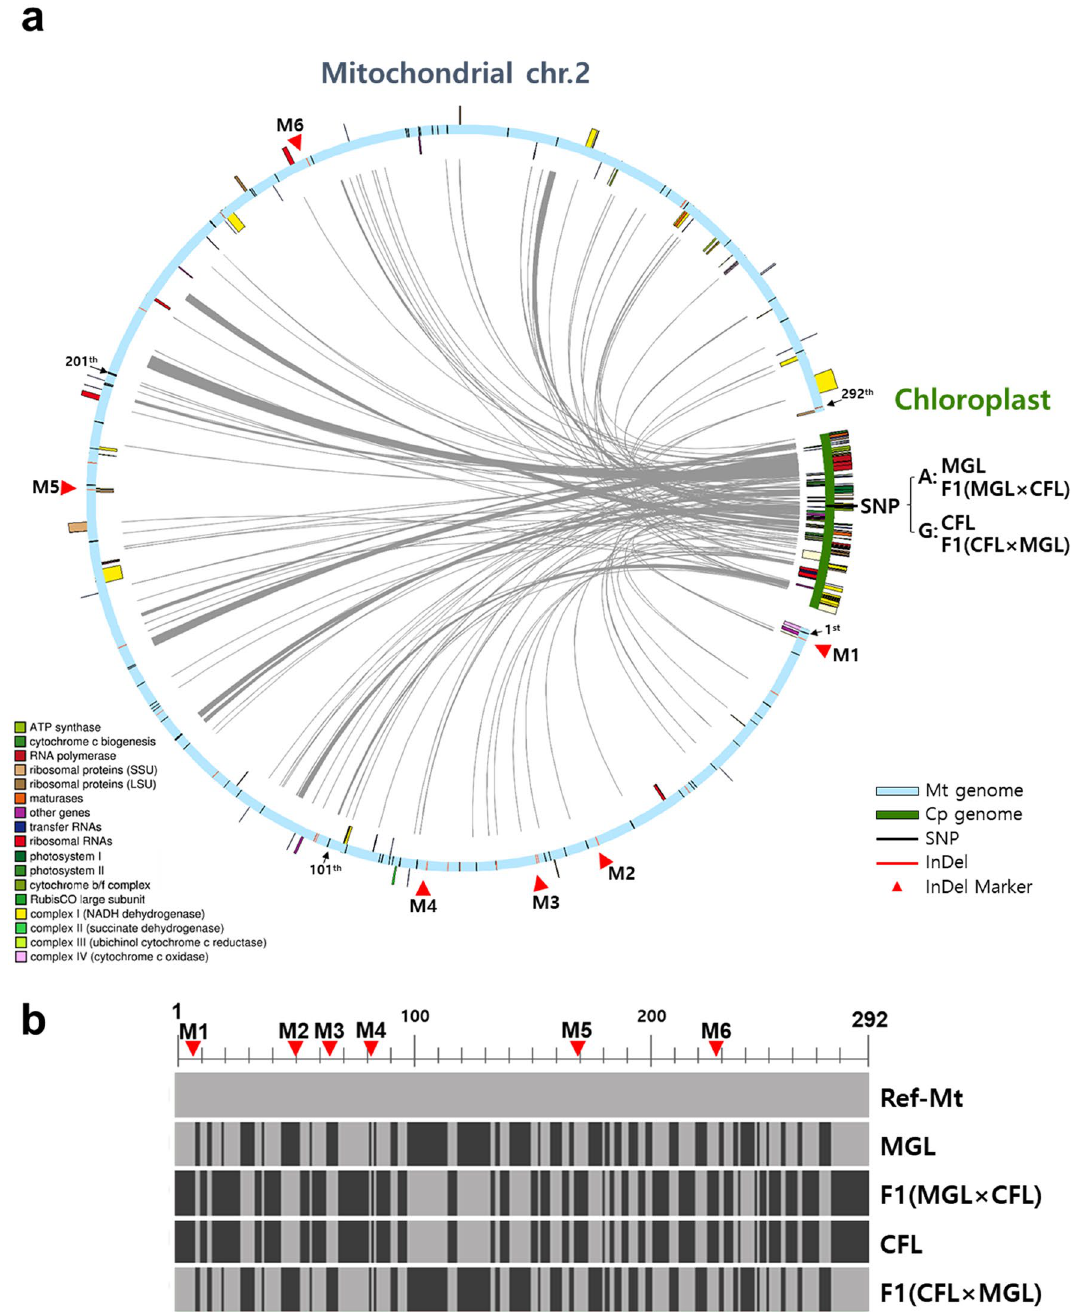
Figure 1. Schematic representation of mitochondrial and chloroplast genome of Cucumis sativus . ( a ) Each colored bar indicates the mitochondrial chromosome 2 retrieved from NCBI (NC_016005.1) and chloroplast genome of the inbred line MGL in this study. One of the pair of the inverted repeat regions in chloroplast genome was removed. Genes transcribed clockwise and counterclockwise are located on the outside and inside of the bar, respectively. The 292 mitochondrial and 1 chloroplast polymorphisms between two parental lines, MGL and CFL, are represented as black lines for SNP and red lines for InDels. The mitochondrial plastid DNAs and their plastid origins are linked with gray line. The positions of six InDel markers (M1 to M6) are labeled with red triangles. ( b ) Genotype comparison of the 292 polymorphic sites in mitochondrial genome of parental lines and F 1 hybrids of reciprocal cross. The same color indicates the same genotype for polymorphic sites among parental lines and F 1 hybrids. Gray-mitochondrial indicates the genotype of the reference mitochondrial genome